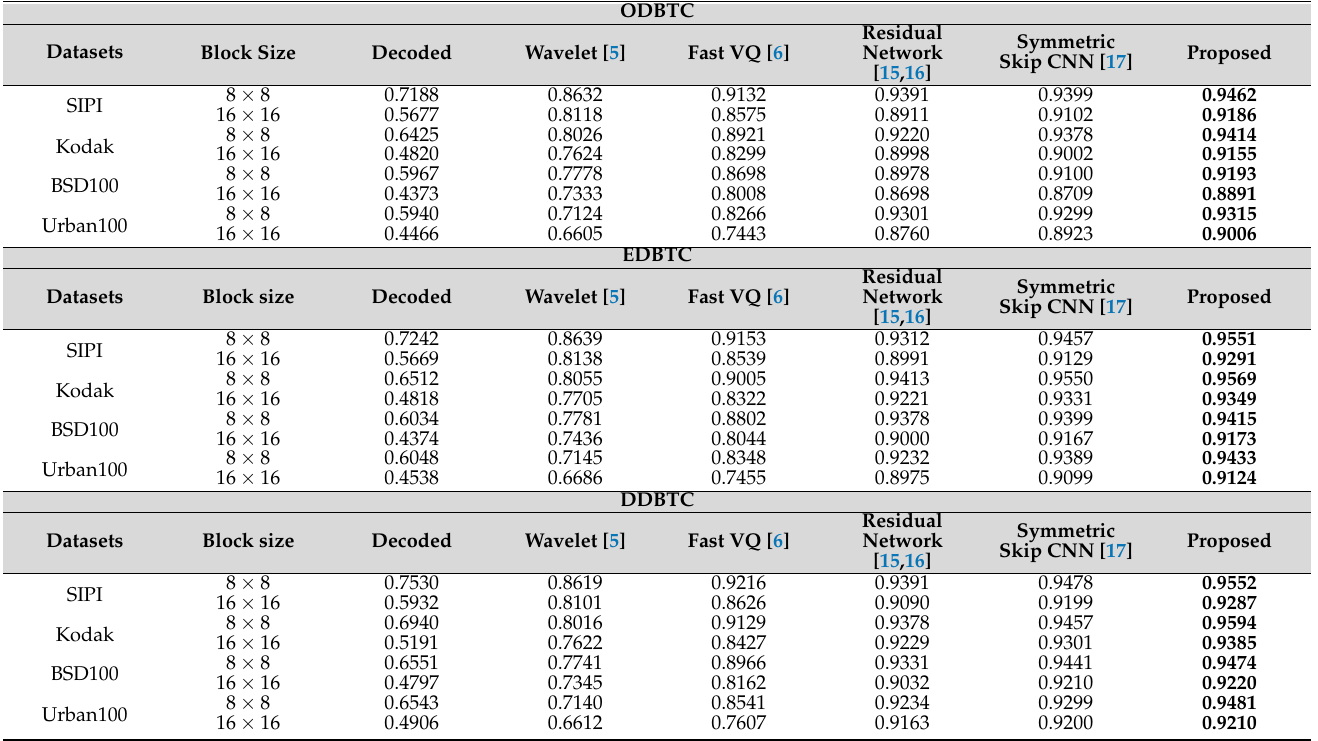
Table 2. Performance Comparison between the Proposed Method and Former Schemes in Terms of SSIM